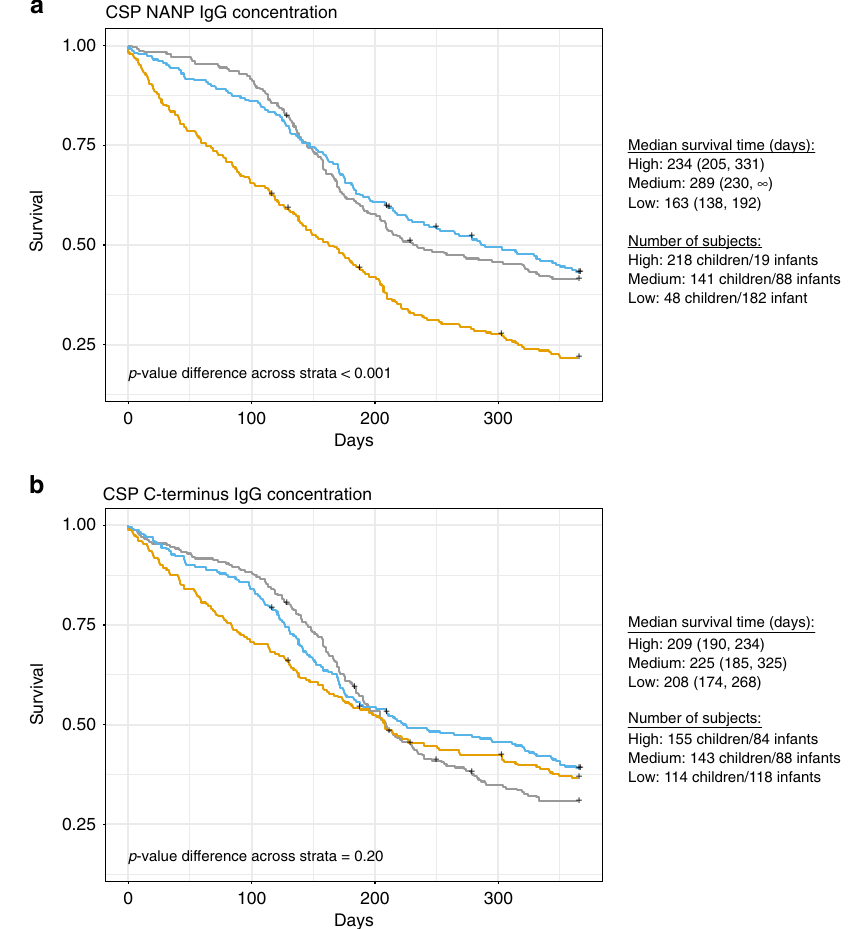
Fig. 3 Effect of CSP antibody concentration on protection against the fi rst malaria episode. Kaplan – Meier estimates of time to the fi rst clinical malaria episode during the 12-month follow-up period after the third vaccine dose by the three tertiles (high in grey; medium in blue; low in yellow) of IgG concentrations (EU mL − 1 ) to NANP ( a ) and to C-terminus ( b ) at month 3 in RTS,S vaccinees. The median survival time (days), i.e., time after which 50% of the cohort has not yet had an event, is shown for each antibody tertile with the corresponding 95% con fi dence intervals. p -values assessing differences in the distribution of survival time across the three strata in each of the subgroups were estimated through the Log-rank test. The number of subjects in each tertile are also indicated next to the plots, strati fi ed by age